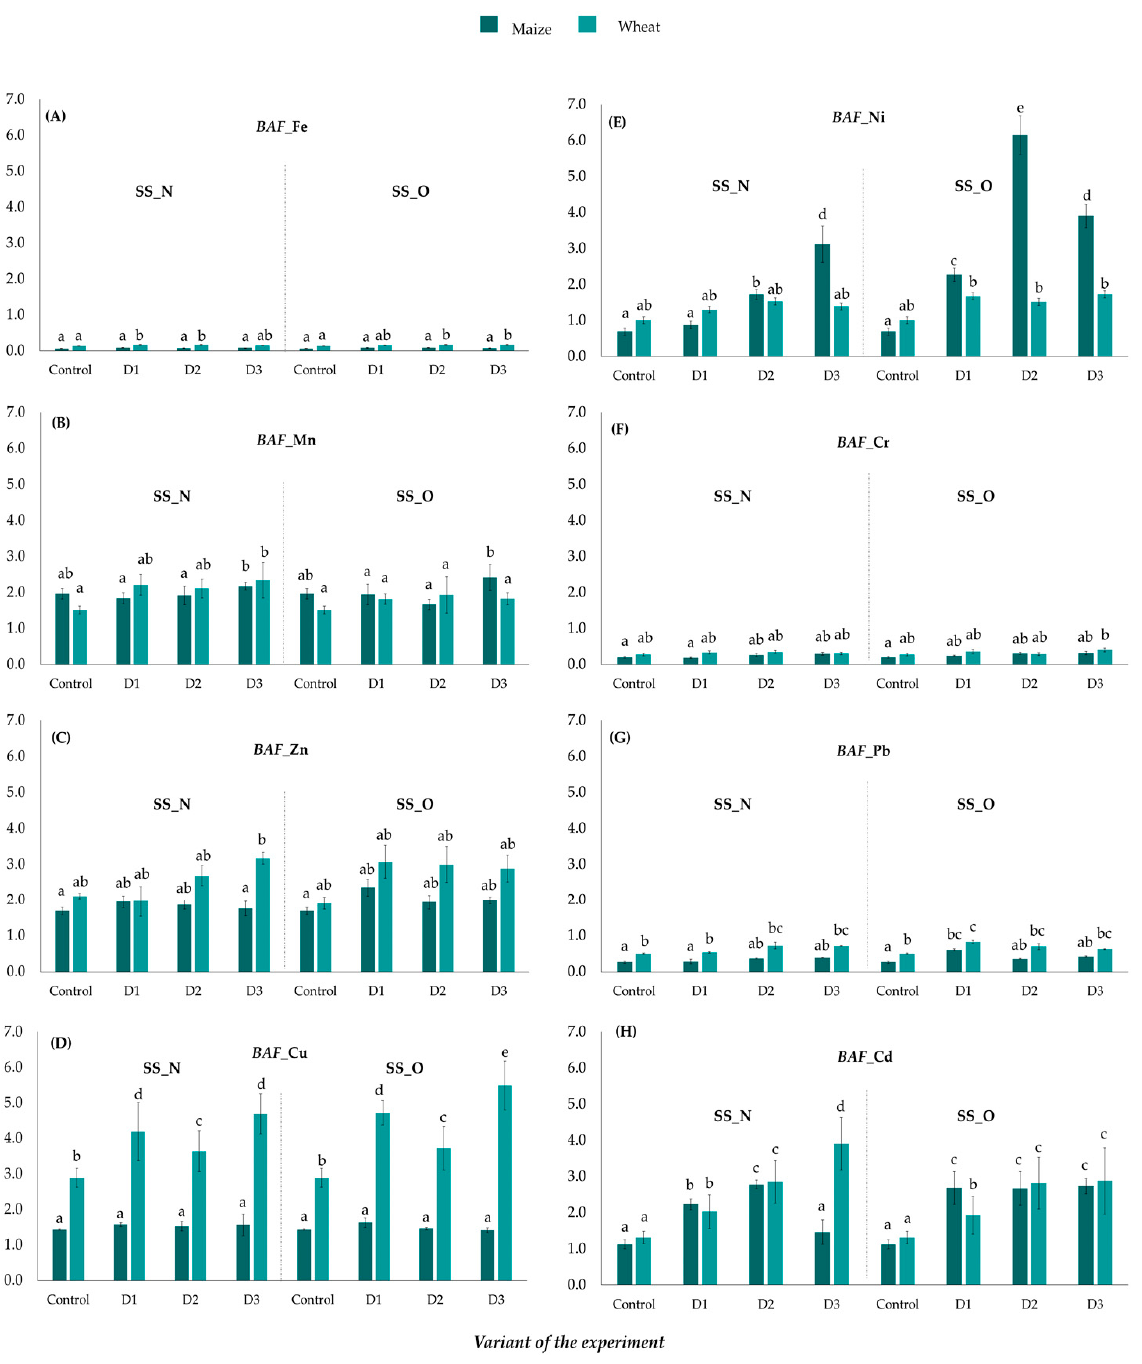
Figure 4. Bioaccumulation factors (BAFs) of Fe ( A ), Mn ( B ), Zn ( C ), Cu ( D ), Ni ( E ), Cr ( F ), Pb ( G ), and Cd ( H ) in aboveground biomass of maize and wheat plants relative to the dose and type of sewage sludge. Mean values ( n = 9) ± standard error. Identical letters denote no significant ( p < 0.05) differences between the experimental objects according to the post hoc Tukey HSD test. Explanation: SS_N—non-ozonated sewage sludge; SS_O—ozonated sewage sludge; D1, D2, D3—dose of sewage sludge—3, 6, 9 Mg ha − 1 , respectively.